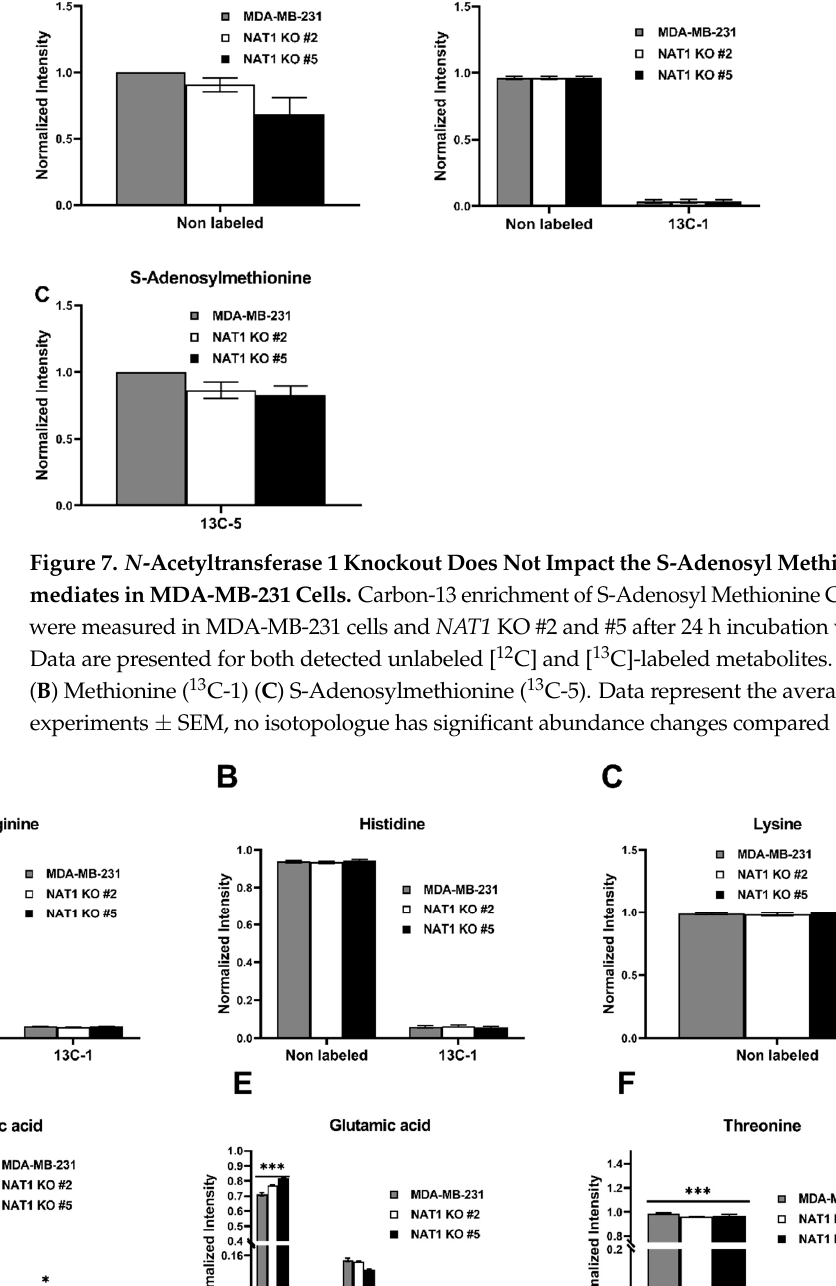
Figure 7. N -Acetyltransferase 1 Knockout Does Not Impact the S-Adenosyl Methionine Cycle Intermediates in MDA-MB-231 Cells . Carbon-13 enrichment of S-Adenosyl Methionine Cycle in-